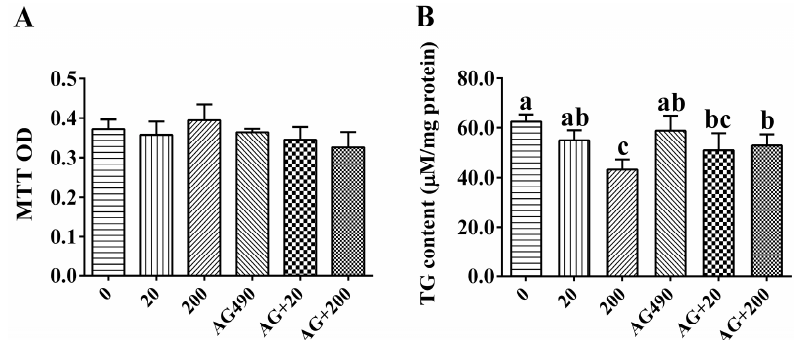
Figure 4. ( A ) Effect of leptin and/or Tyrphostin B42 (AG490) on cell livability in primary hepatocytes from S. hasta ; ( B ) Effect of leptin and/or AG490 on hepatocytes TG accumulation. Values are mean ± SEM ( n = 4). Bars that share different letters indicate significant differences among groups ( p < 0.05), and bars without different lowercase letters indicate no significant differences among groups ( p < 0.05).